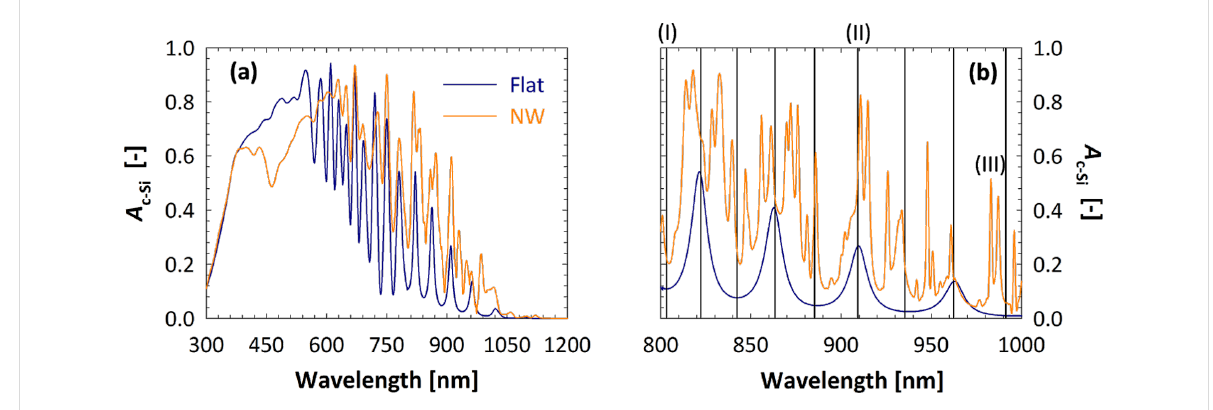
Figure 4: Calculated absorption in c-Si, as function of the wavelength, of the flat reference (FLAT, blue) and nanowire (NW, orange) device models. In (a), the range 300–1200 nm is considered, while (b) focuses on the spectrum between 800 and 1000 nm. Black vertical lines in (b) indicate the po- sition of interference resonances, calculated with Equation 2. The corresponding electric field distributions are presented in Figure 5.